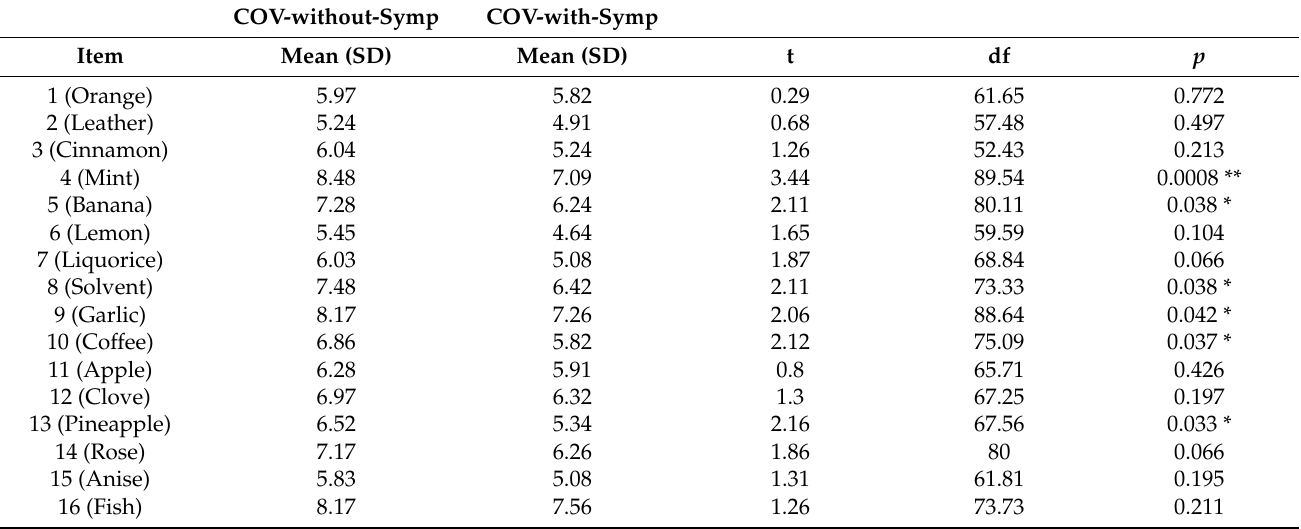
Table 5. Average scores per item in Identification–Subjective Intensity